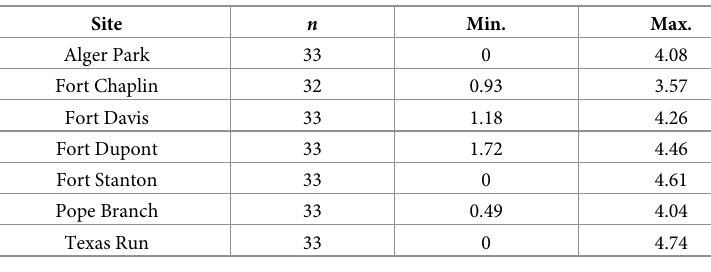
n denotes number of samples. Min. indicates minimum measurement. Max. represents maximum measurement. SD signifies standard deviation.